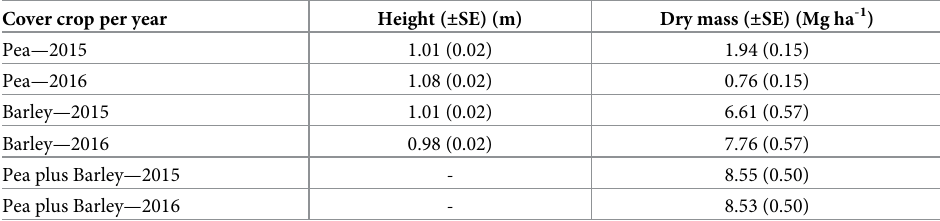
Table 4. Mean height and dry biomass, and standard errors of the cover crop mixture in 2015 and 2016 growing seasons. Cover crop per